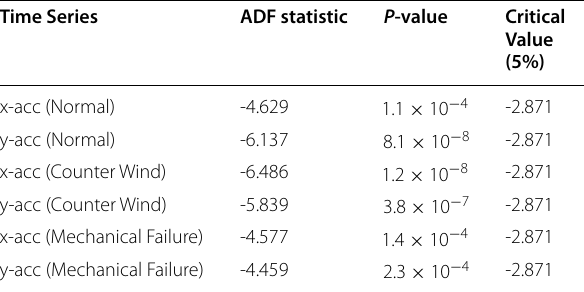
Table 3 Comparison of characteristics of five models via conducting normalization (Norm.), keeping temporal structure (Temporal), carrying out low‑pass filtering (Filter), executing transformation (Transform), and key features (Features)